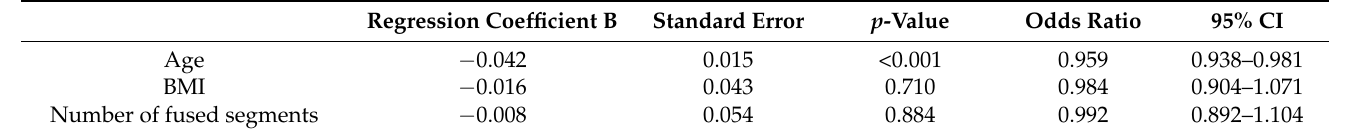
Table 4. Multivariate regression